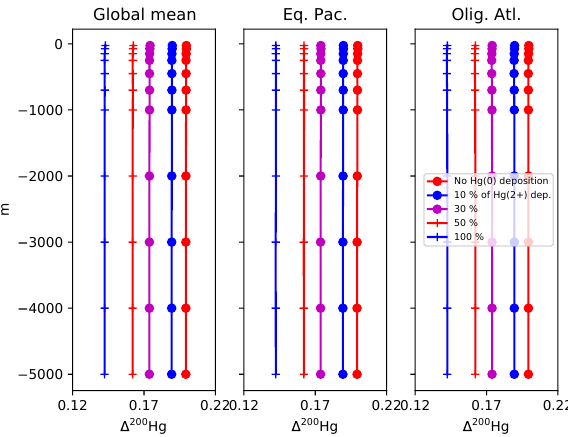
Figure 15. Profiles of the (cid:49) 200 Hg isotopic composition of Hg(II) for different values of the dry deposition (Hg(0)) flux. The rate of wet deposition is the same for all runs. Locations for the Eq. Pac. and Olig. Atl. profiles are given in Fig. 4.